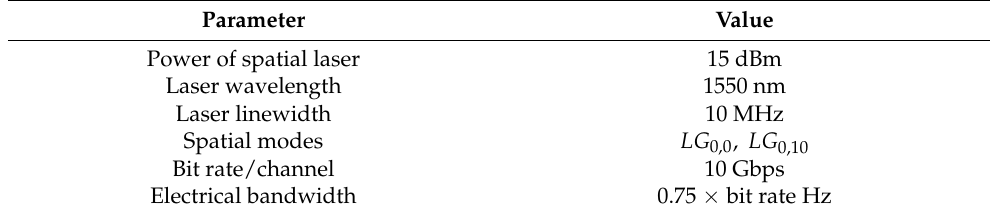
Table 5. Parameters used in the simulation